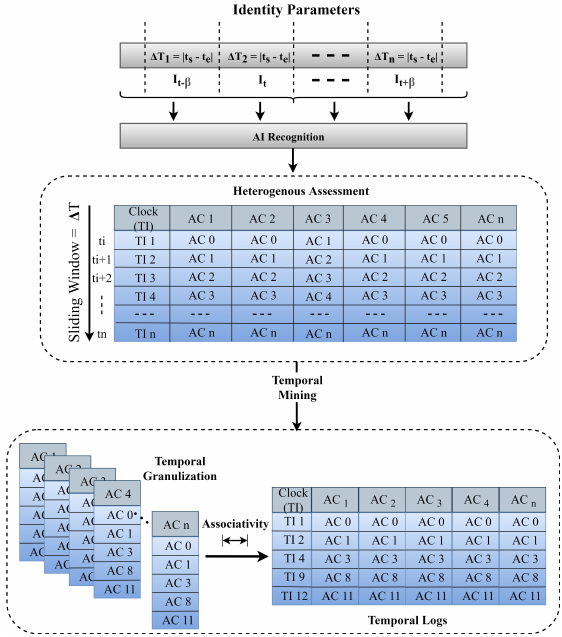
Figure 3. Granulation